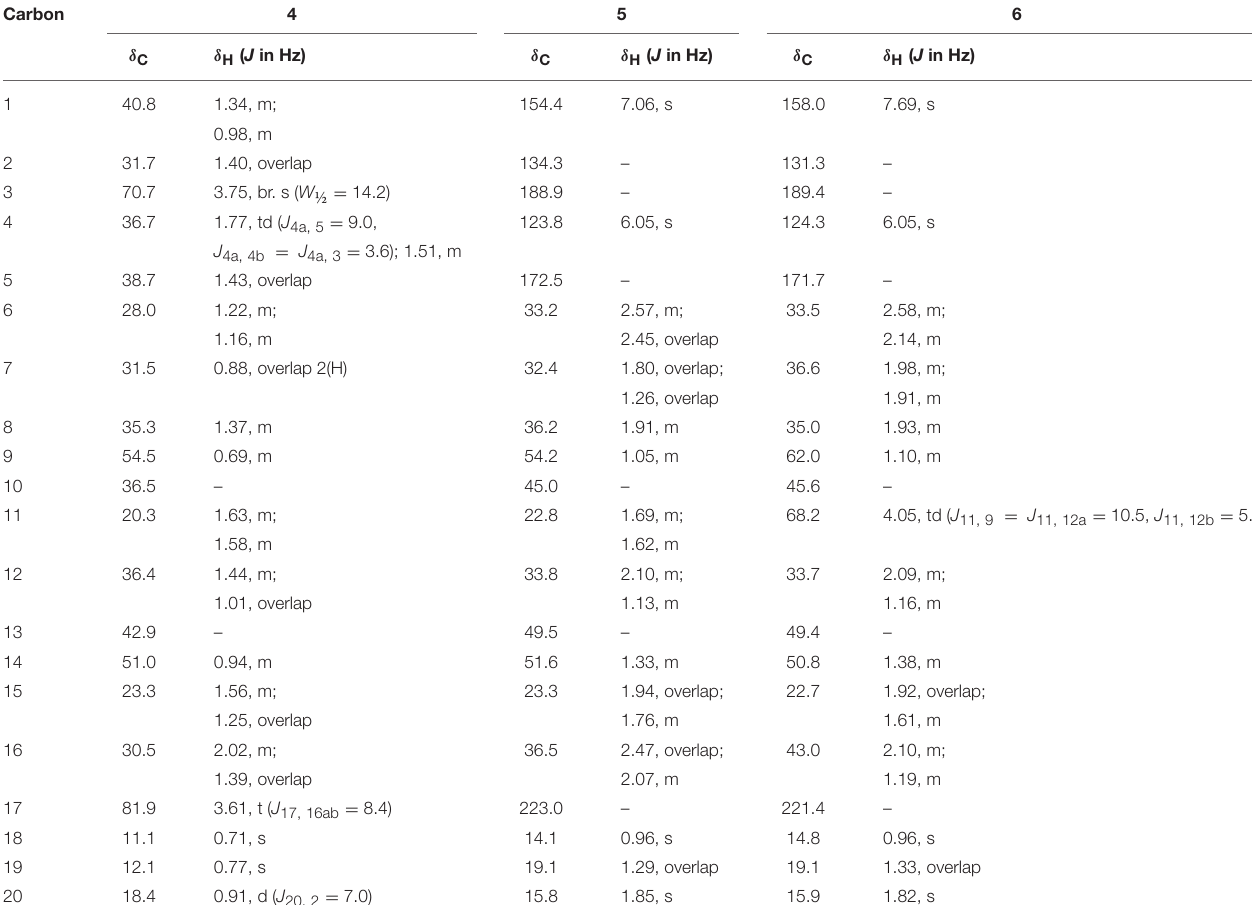
TABLE 2 | 13 C- and 1 H-NMR chemical shift data ( J and W 1 / 2 in Hz) of compounds 4 – 6 ( δ ppm). Carbon